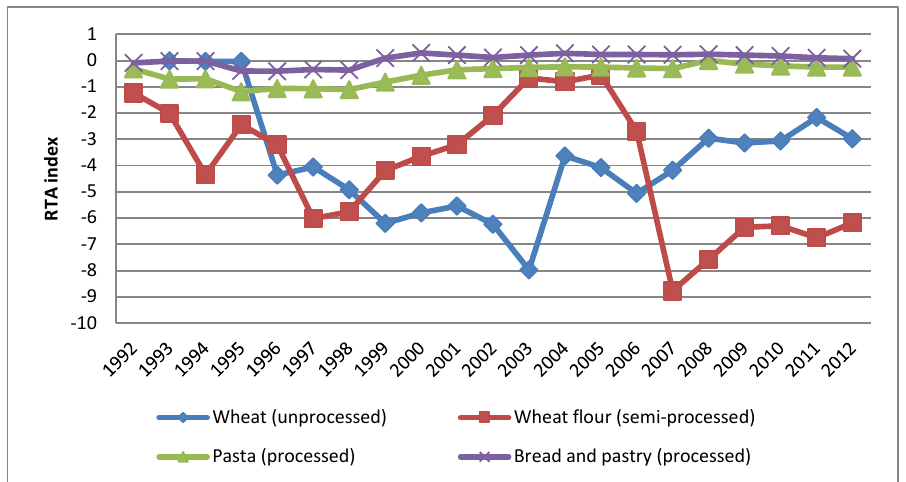
FIGURE A2: Trends in RTA index values for unprocessed, semi-processed and processed wheat in